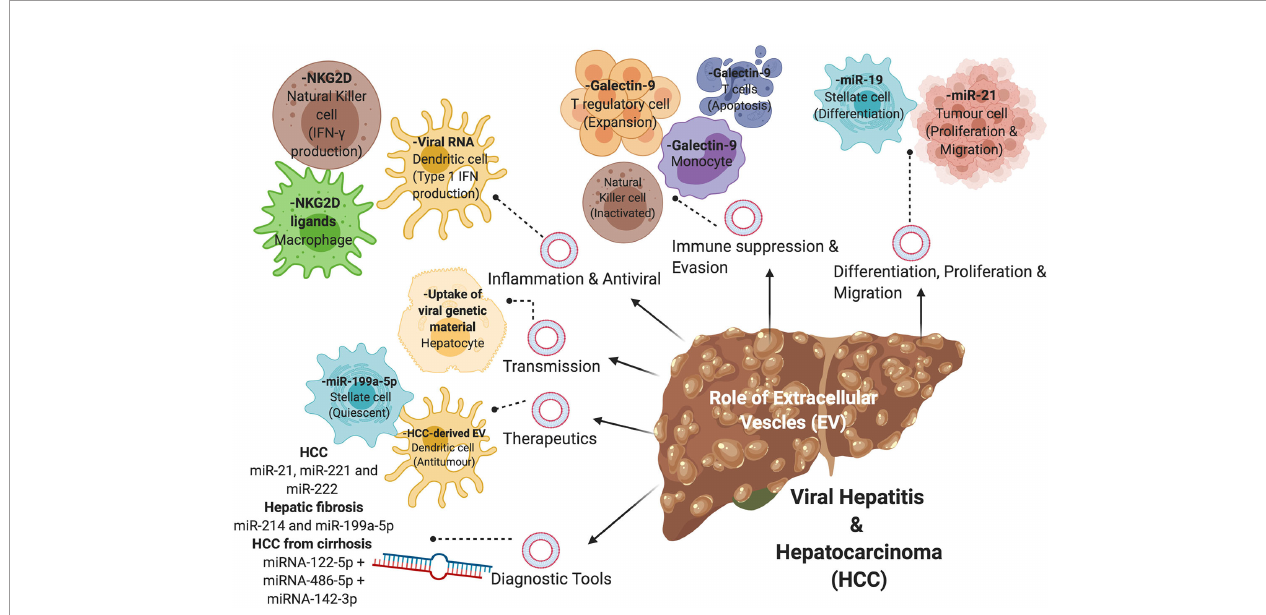
FIGURE 2 | The role of extracellular vesicles (EVs) in viral-associated liver disease. EVs containing nucleic acids, proteins, or metabolites are involved in the disease progression of viral hepatitis and HCC via various mechanisms, including differentiation of hepatic stellate cells, proliferation and migration of tumor cells, immune suppression and evasion, in fl ammation and antiviral properties, and transmission of virions. EVs can also be used in the diagnosis and treatment of viral-associated liver